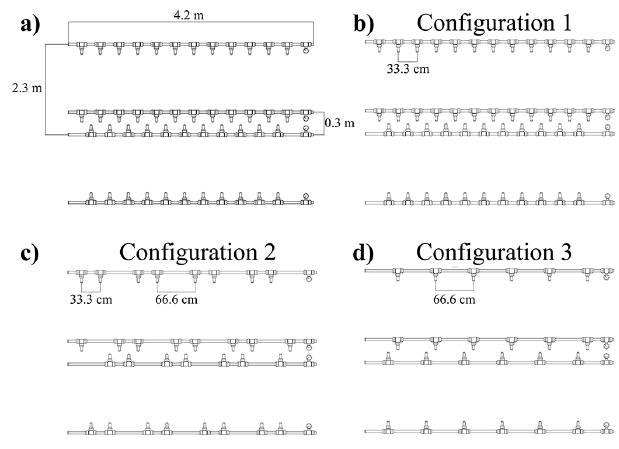
Figure 2. Nozzle configurations for three intensities with nozzle spacing, resulting intensity, and experimental coefficient of uni- formity of water application. (a) Spacing between nozzle lines. (b) 46 nozzles, 61.6mmh − 1 , CU = 75 . 64%. (c) 31 nozzles,